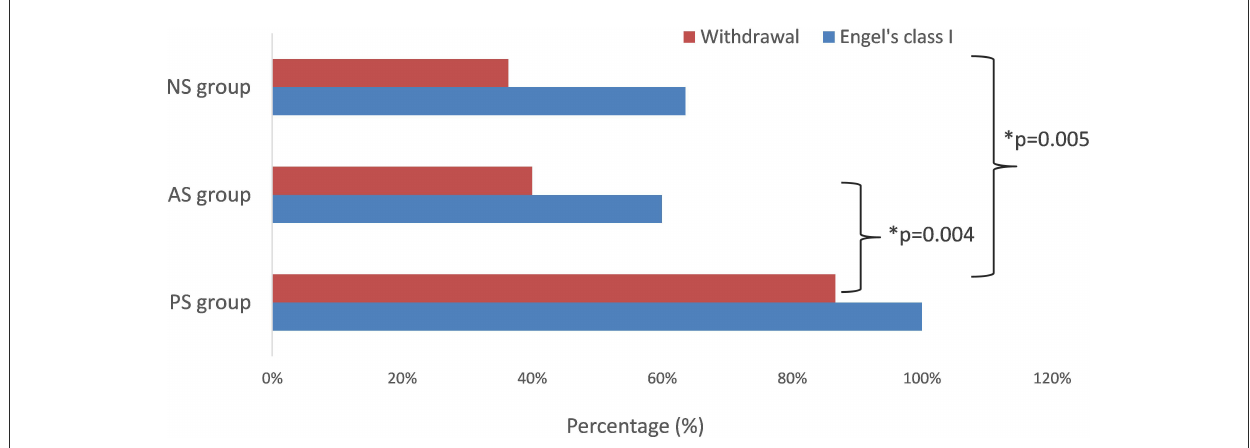
FIGURE4 The seizure-free rate and withdrawal rate in different groups. The difference in seizure-free rate was significant ( p = 0.004, PS vs. AS; p = 0.005, PS vs. NS). *means significant different.